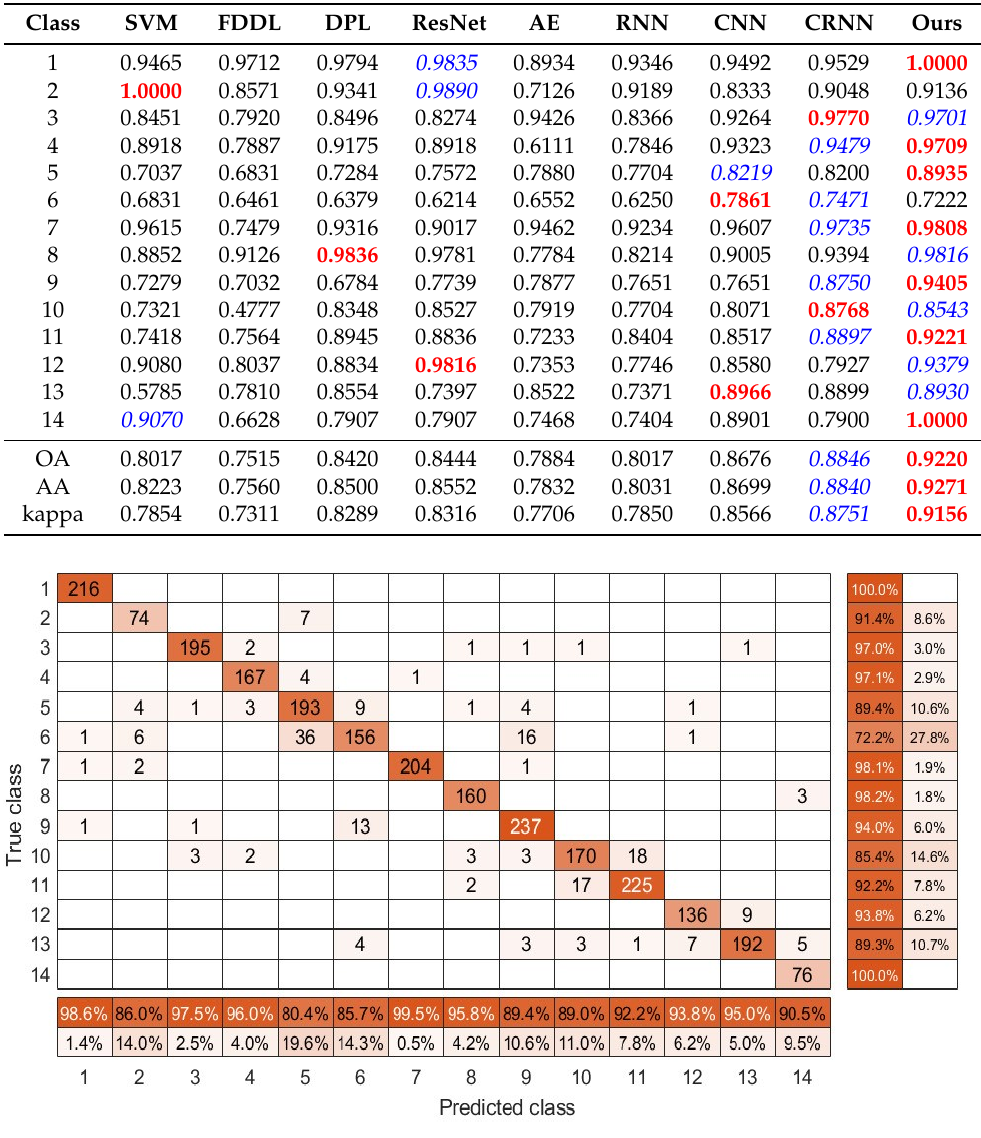
Table 2. Classification Accuracy for Botswana Dataset. The red bold fonts and blue italic fonts indicate the best and the second best performance.